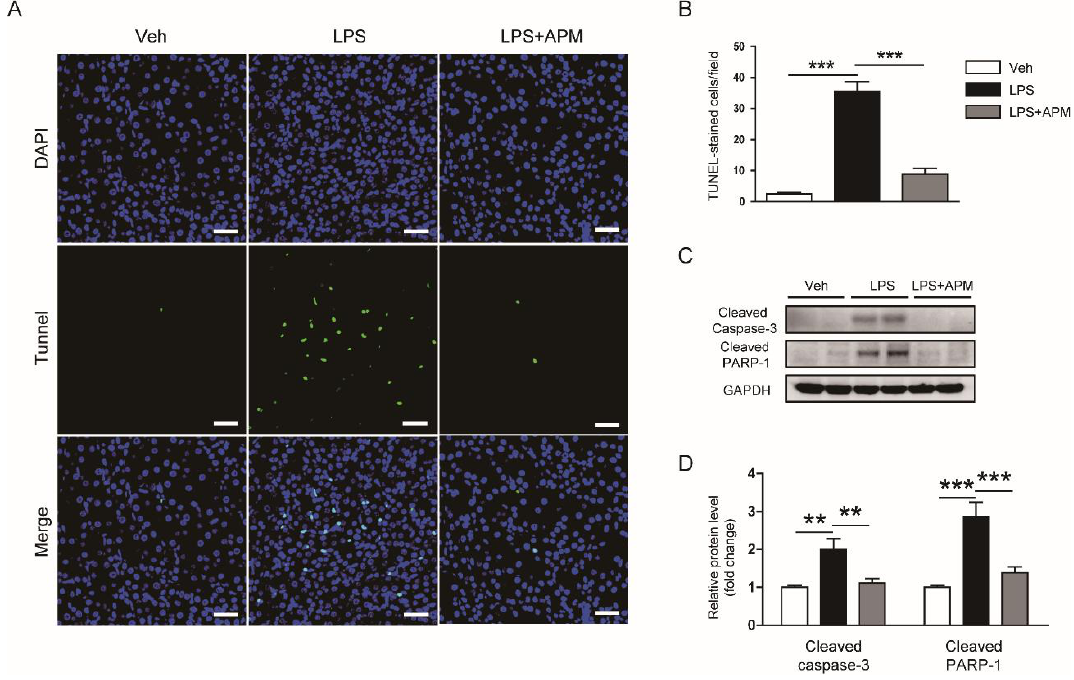
Figure 7. Effect of apamin on LPS-induced apoptosis. ( A ) Terminal deoxynucleotidyl transferase-mediated deoxyuridine triphosphate nick end labeling (TUNEL) staining of kidney tissues. Scale bars: 25 μm. ( B ) Number of cells stained with TUNEL. ( C ) Immunoblotting of cleaved caspase-3 and cleaved poly(ADP-ribose) polymerase-1 (PARP-1). ( D ) Quantification of immunoblots for cleaved caspase-3 and cleaved PARP-1. n = 8 per each group. ** p < 0.01 and *** p < 0.001.